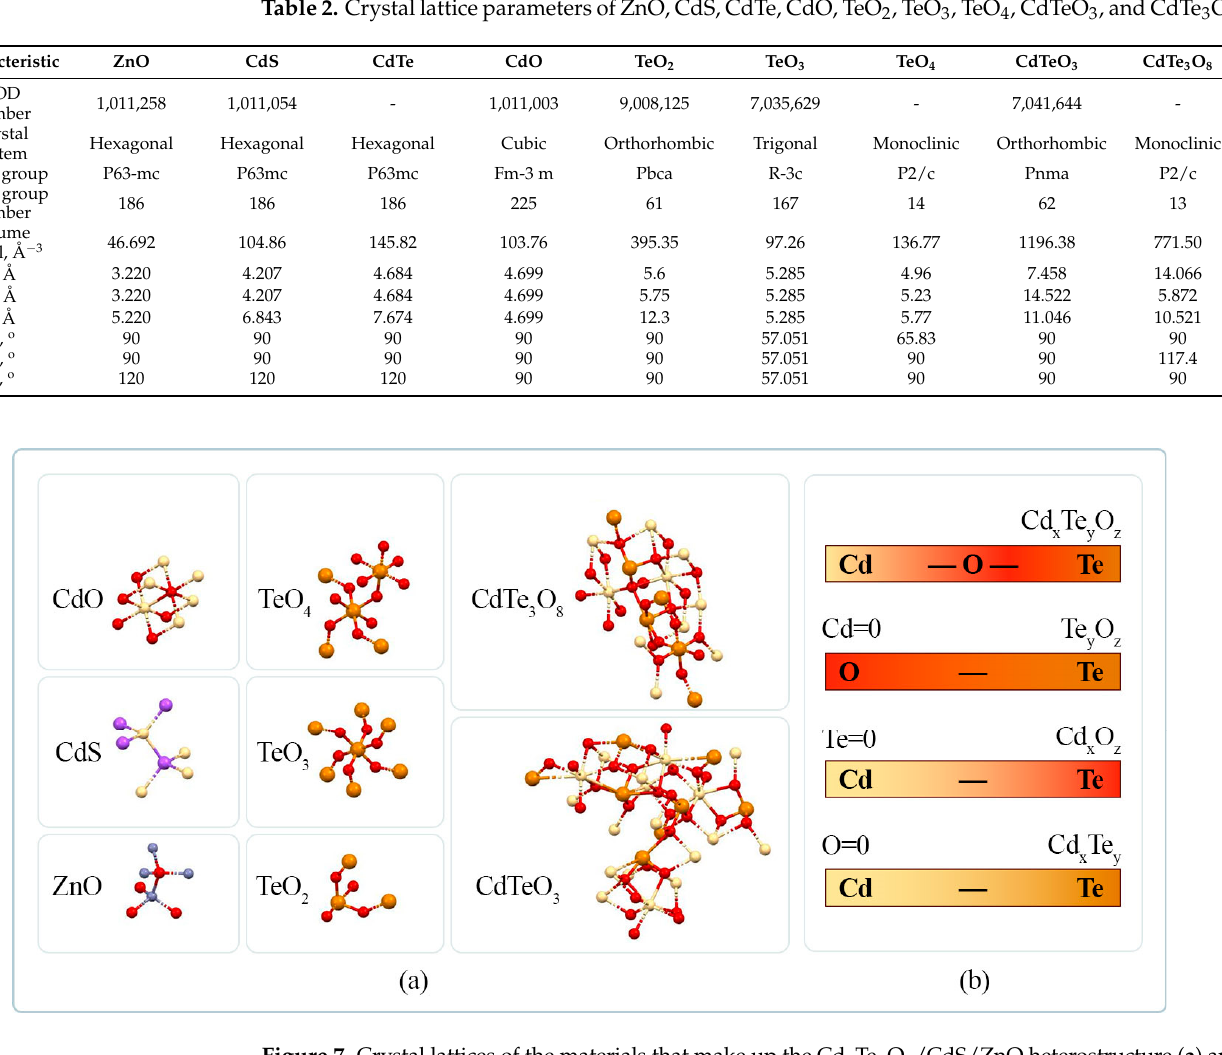
Table 2. Crystal lattice parameters of ZnO, CdS, CdTe, CdO, TeO 2 , TeO 3 , TeO 4 , CdTeO 3 , and CdTe 3 O 8 .